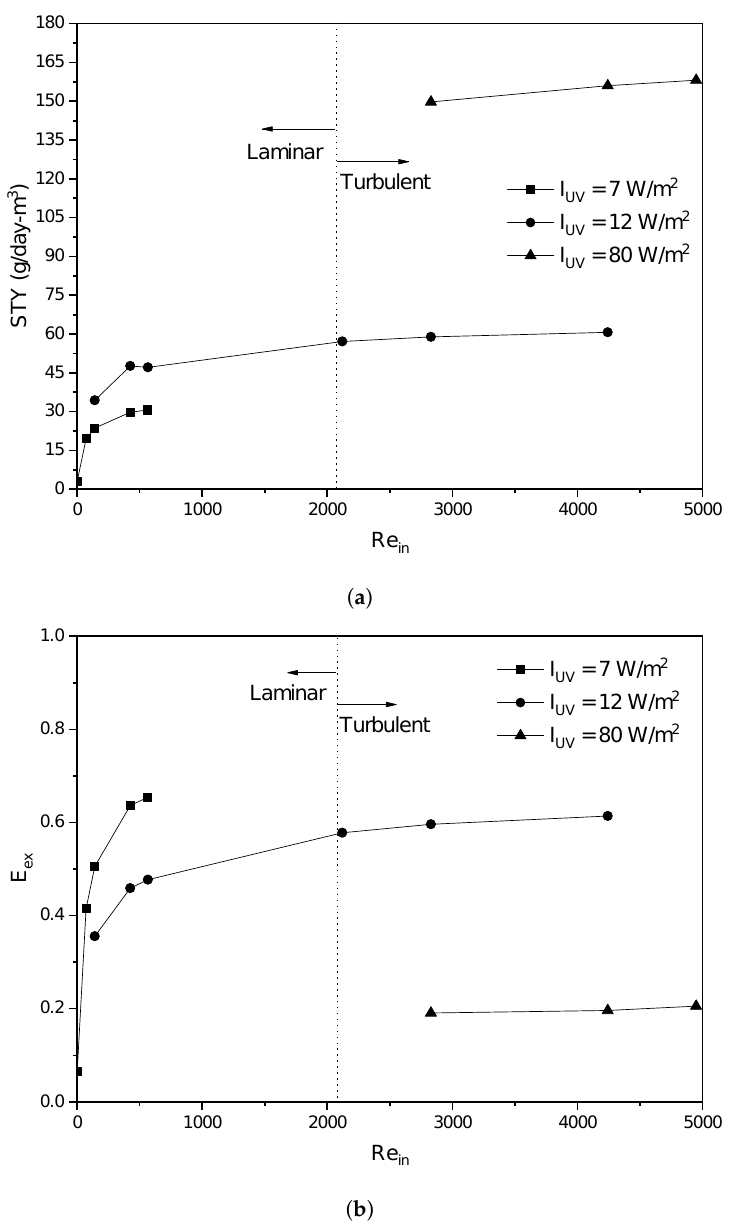
Figure 13. ( a ) Space-time Yield, and ( b ) Effectiveness External factor in terms of Reynolds at the inlet. On the other hand, the influence of inlet velocity and surface radiation intensity on PSTY was analyzed as shown in Figure 14. The PSTY , contrary to the STY , presented the maximum value under solar radiation. For a surface radiation intensity of 12 W/m 2 and an inlet velocity of 0.2 m/s, a PSTY of 45 g/day-kW is obtained by increasing the surface radiation intensity to 80 W/m 2 , and the PSTY decreases to a value of 4.5 g/day-kW because the energy increase is more significant than the STY improvement. Therefore, it is possible to affirm that the PSTY can be maximized up to a value of 45 g/day-kW at an inlet velocity of 0.2 m/s, solar radiation for external illumination, and internal radiation by UV-LEDs of 14 W/m 2